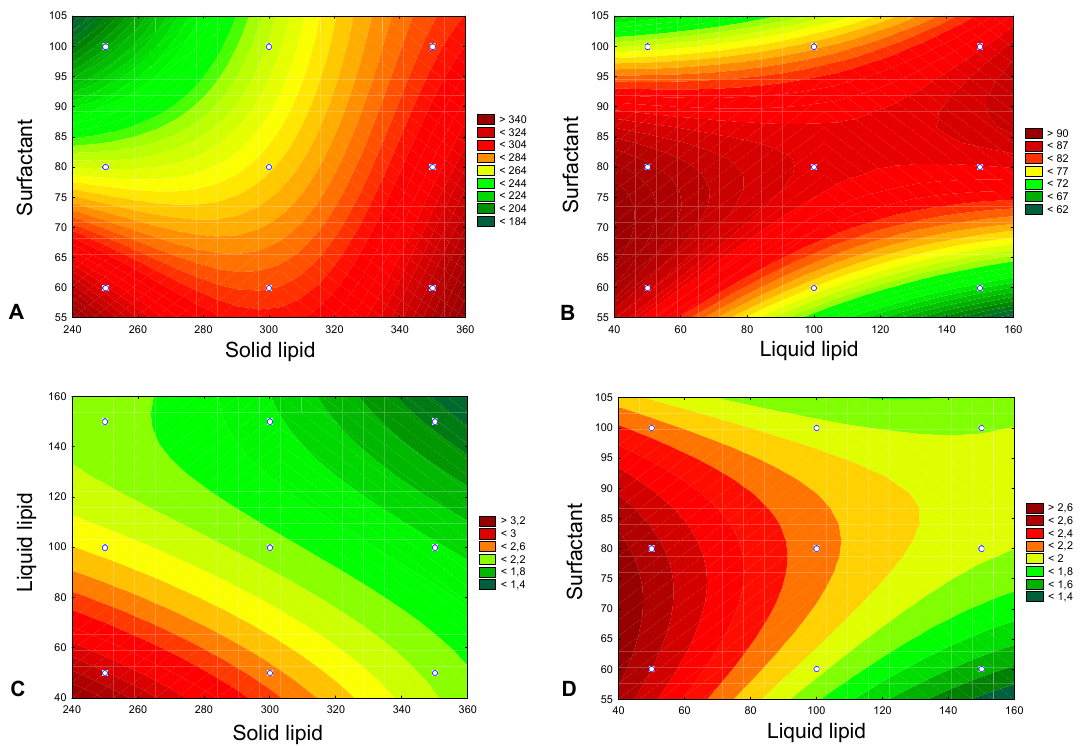
Figure 1. Response contour plots, representing the statistically significant effects ( p -value < 0.05), namely ( A ) the effect of the amount of solid lipid ( X 1 ) and amount of surfactant ( X 3 ) on particle size ( Y 1 ), ( B ) the effect of the amount of liquid lipid ( X 2 ) and amount of surfactant ( X 3 ) on encapsulation efficiency ( Y 2 ), ( C ) the effect of the amount of solid lipid ( X 1 ) and amount of liquid lipid ( X 2 ) on loading capacity ( Y 3 ), and ( D ) the effect of the amount of liquid lipid ( X 2 ) and amount of surfactant ( X 3 ) on loading capacity ( Y 3 ).